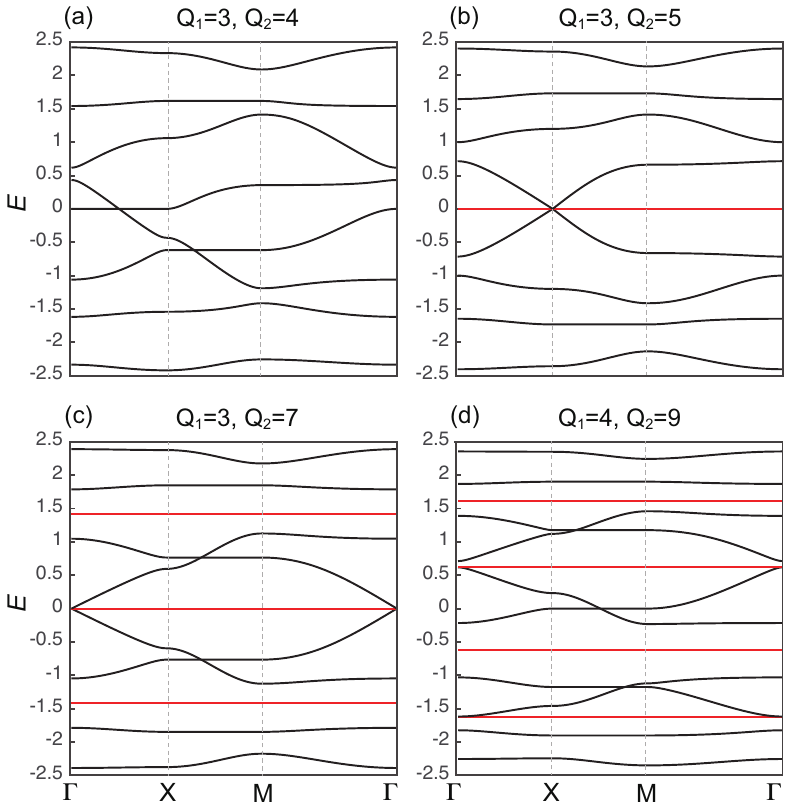
Figure 3. In ( a – d ), we plot band spectra of rectangular network superstructures with Q 1 (cid:54) = Q 2 . Red lines denote flat bands. Refer to Figure 1a for the lattice